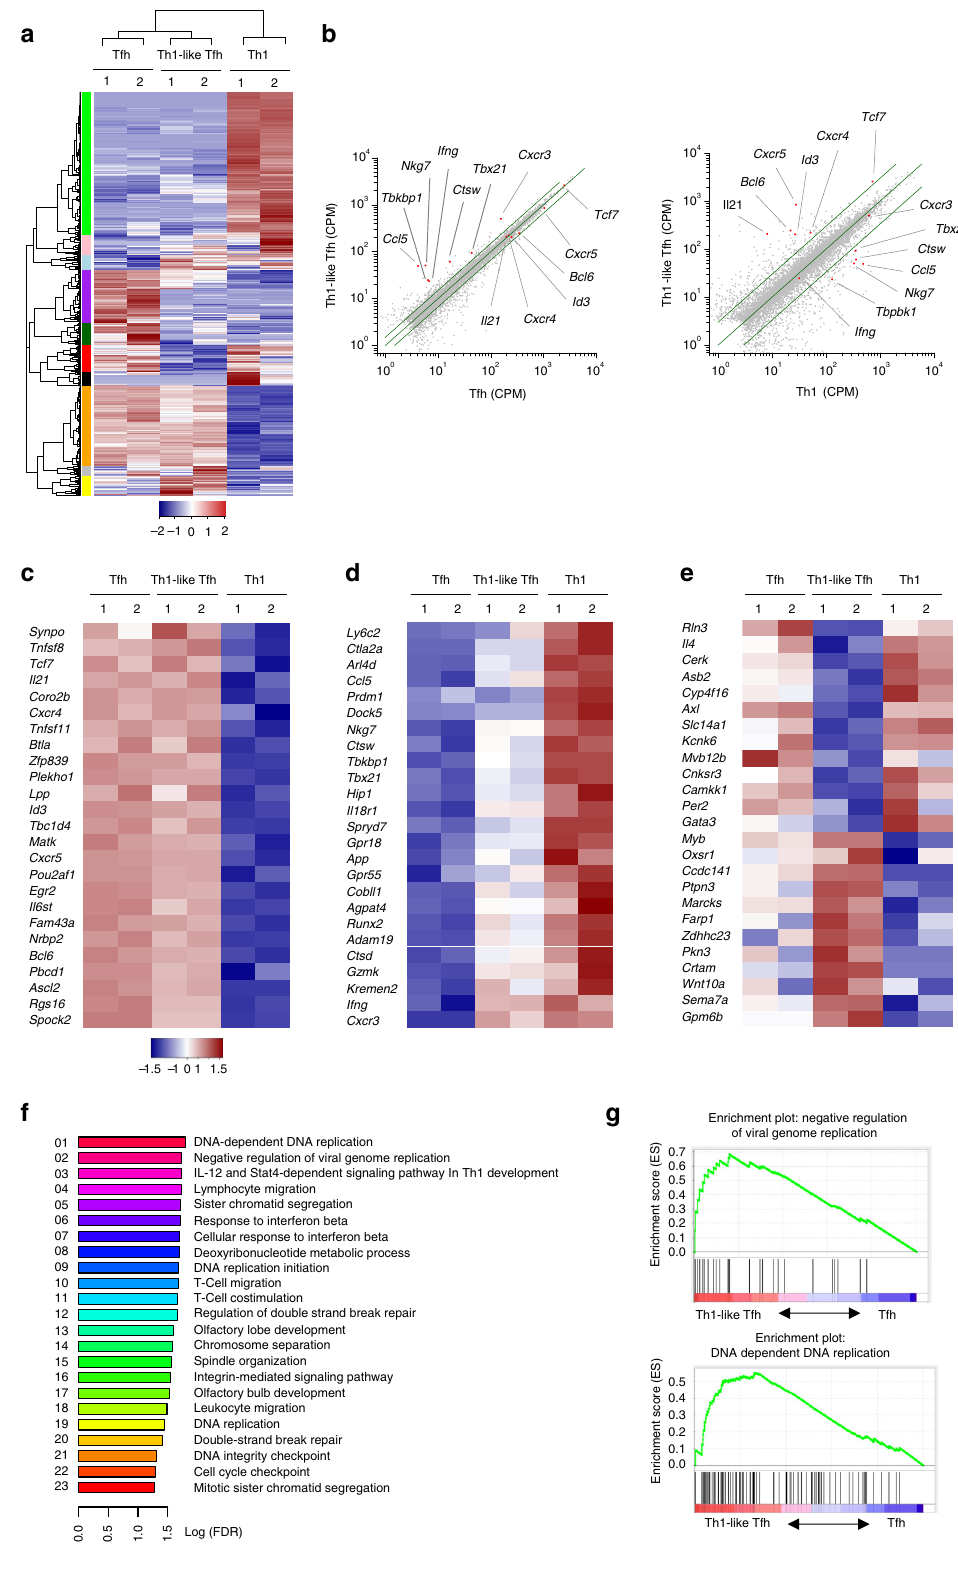
augmented (Supplementary Fig. 7). To address whether Tfh cells or Th1 cells are the dominant T cell subset in providing help to the elicitation of ZIKV-speci fi c neutralizing antibody responses, we infected Bcl6 fl / fl mice (WT) and Bcl6 fl / fl Cd4- Cre mice (that